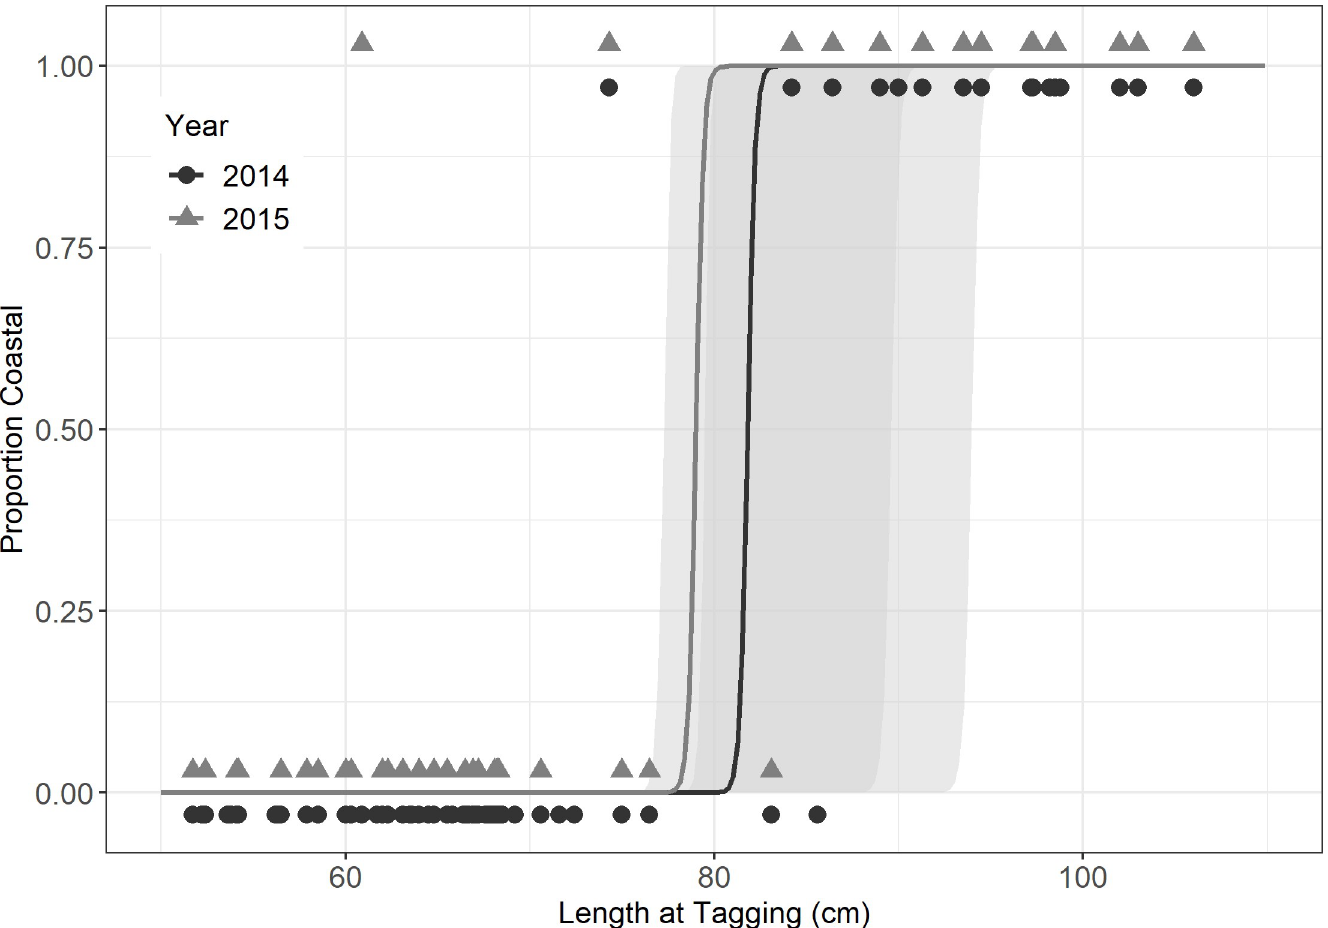
Fig 4. Size-dependent emigration by study striped bass. GLMM fits of ocean incidences versus total length for striped bass classified based on positive or nil detections in shelf arrays. 95% confidence interval ellipses are shown.